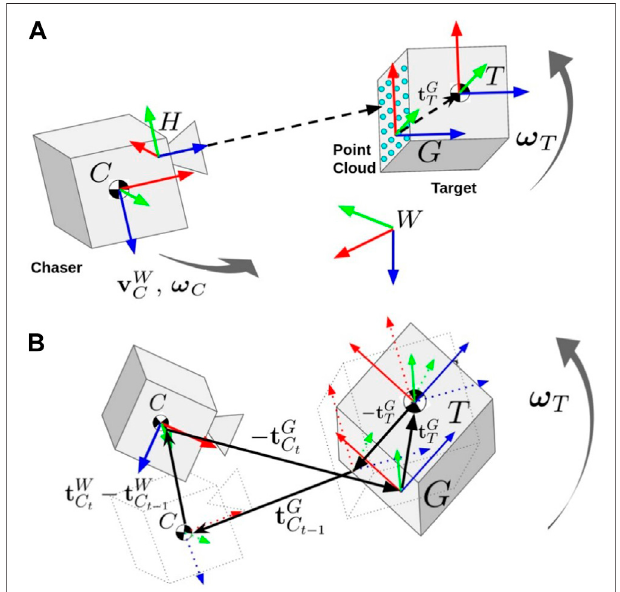
FIGURE 1 | (A) The relevant coordinate frames for estimation of the Chaser and Target states and Target inertial parameters. The Chaser ’ s body frame C moves while the 3D ToF camera (frame H ) collects point cloud measurements of the Target. The Target ’ s body frame ( T ) tumbles around its center of mass. The geometric frame ( G ) origin is de fi ned at the centroid of the fi rst point cloud measurement with an orientation matching the Target ’ s body frame. There is a constant translation vector t G T between the Target ’ s body frame and geometric frame which must be estimated. (B) The rotation kinematic factors that link the otherwise separate Target and Chaser posechainsinthefactorgraphformulationarealsodepicted.Theboldvectors in the image must sum to zero to satisfy the factor ’ s